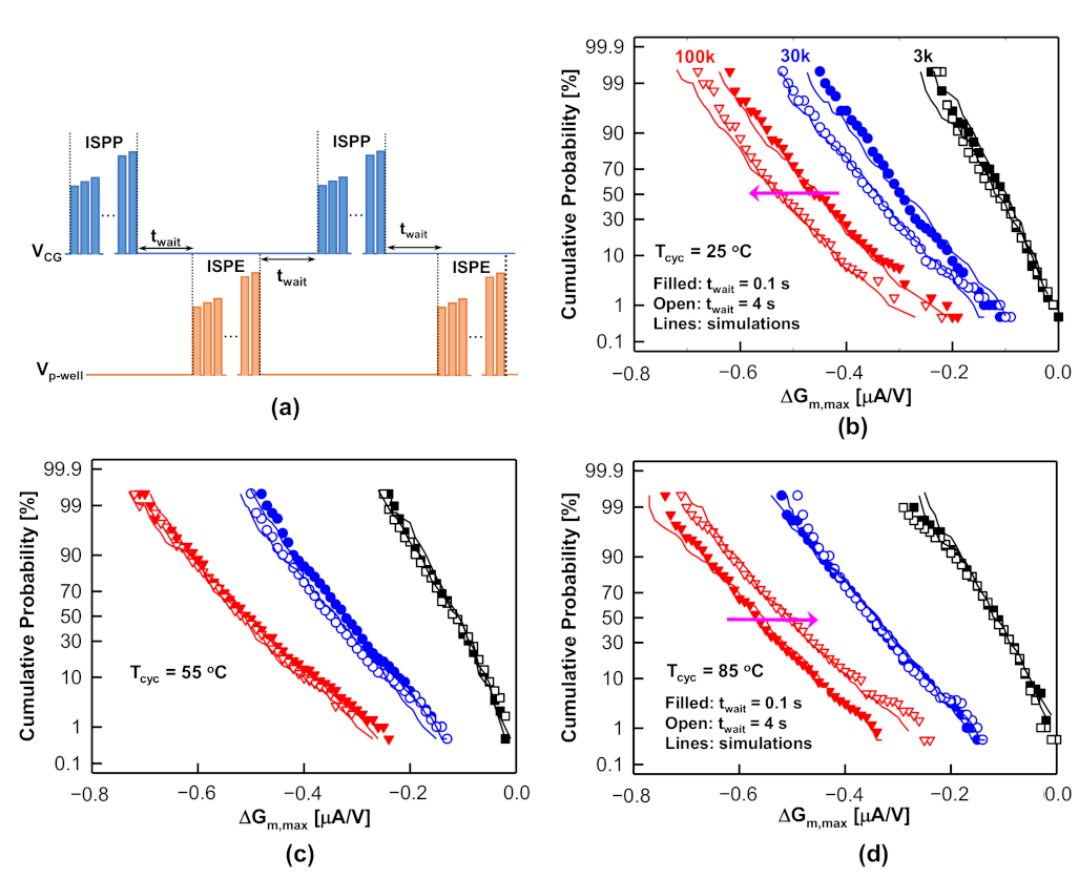
Figure 14. ( a ) Different values of t wait introduced between P/E cycles. ∆ G m , max distributions for cells on WL15 selected measured (symbols) and simulated (lines) for different values of t wait at T cyc of ( b ) 25 °C, ( c ) 55 °C, and ( d ) 85 °C. Reprinted from [47].